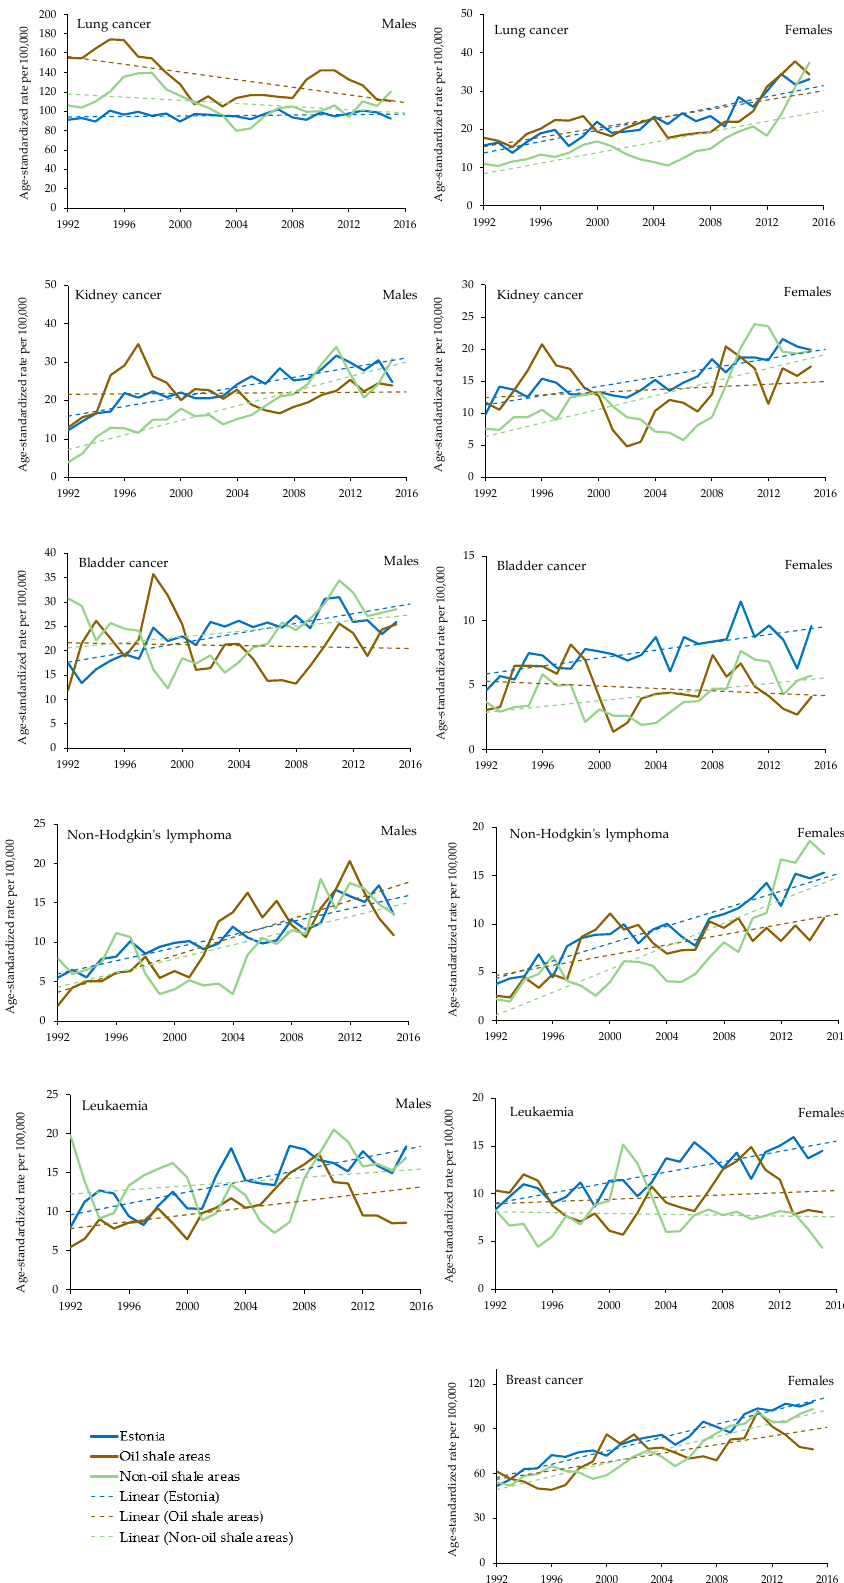
Figure 2. Age-standardized incidence rates for cancer sites in oil shale (brown line) areas, non-oil shale (green line) areas and Estonia overall (blue line). Cancer trendlines are represented with dashed lines.